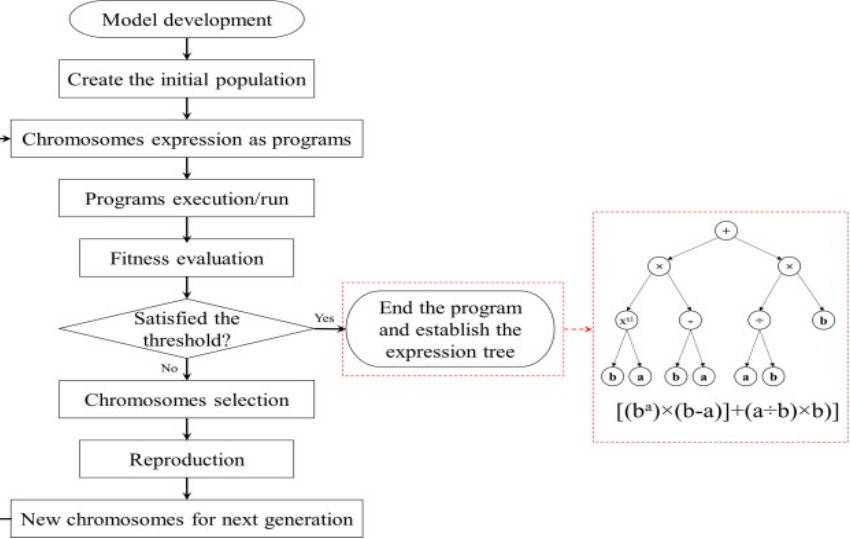
Figure 10. GEP modeling operation flowchart [36] .